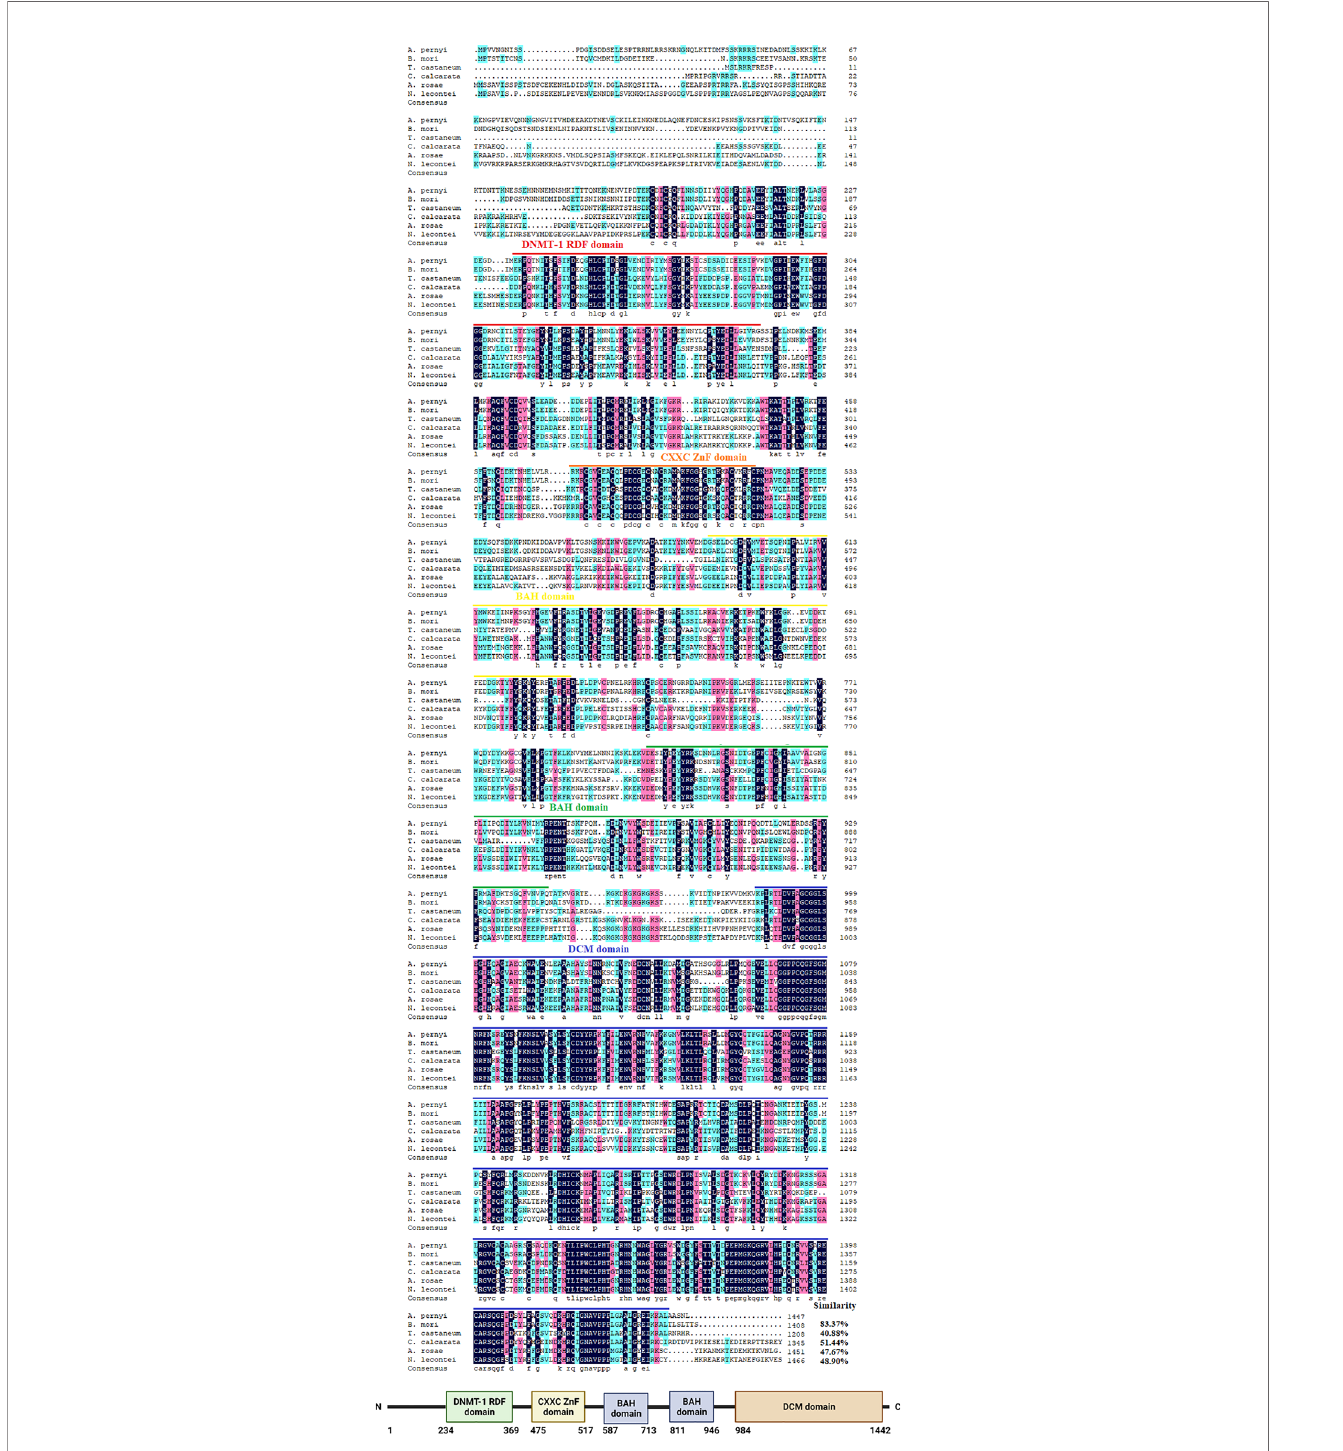
FIGURE 1 | Alignment of the ApDNMT-1 protein with homologous proteins. The ApDNMT-1 deduced amino acid sequence was aligned with other DNMT-1 protein sequences. The sequences for alignment analysis are the following: accession no. NP_001036980.1 ( Bombyx mori ), accession no. ASA69505.1 ( Tribolium castaneum ), accession no. XP_026671099.1 ( Ceratina calcarata ), accession no. XP_012254091.1( Athalia rosae ), and accession no. XP_015517160.1 ( Neodiprion lecontei ). Identi fi ed domains were labeled as DNMT1-RDF, DNA methyltransferase replication foci domain which is indicated by a red line; ZnF, Zinc fi nger domain is indicated by the orange line; BAH, Bromo adjacent homology domain is shown in yellow line; DCM, DNA-cytosine methyltransferases domain is shown in green line Cys-rich, cysteine-rich ADD domain is presented in the blue